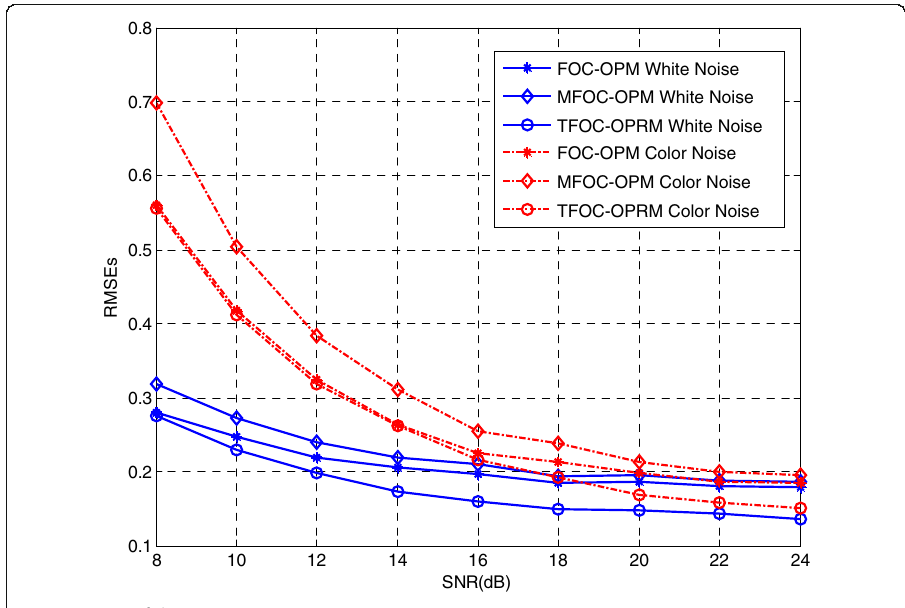
Fig. 2 RMSEs of the DOAs versus SNR